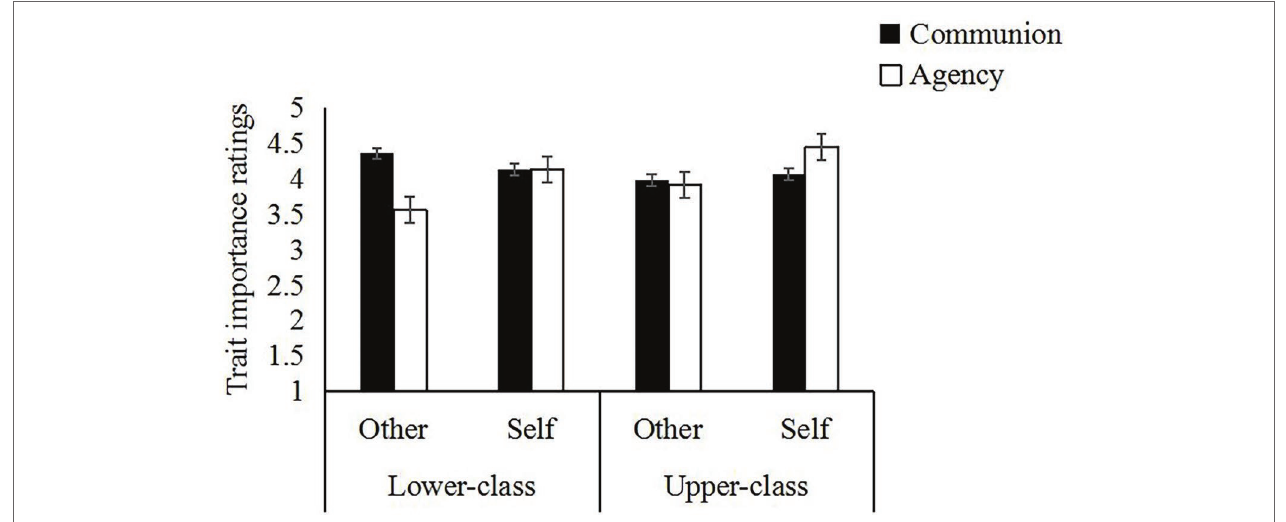
FIGURE 2 | Ratings on importance of communion and agency by lower- versus upper-class